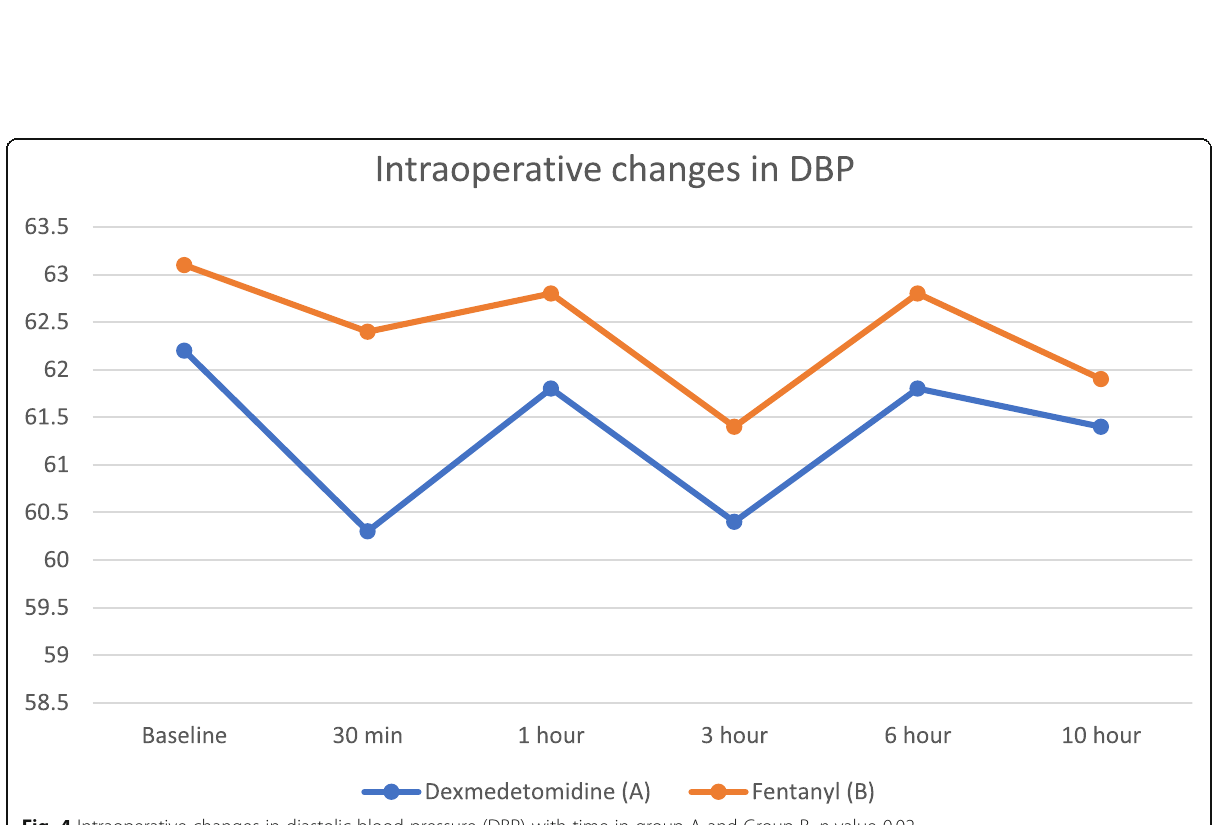
Fig. 4 Intraoperative changes in diastolic blood pressure (DBP) with time in group A and Group B. p value